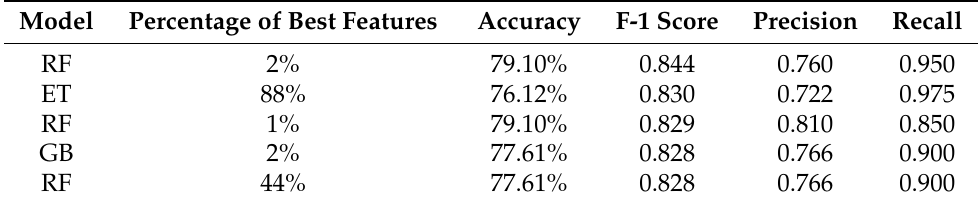
Table 3. The top five models on the testing dataset of Group SN in classifying memory encoding and retrieval. The models are ranked based on their F-1 score on the testing dataset.